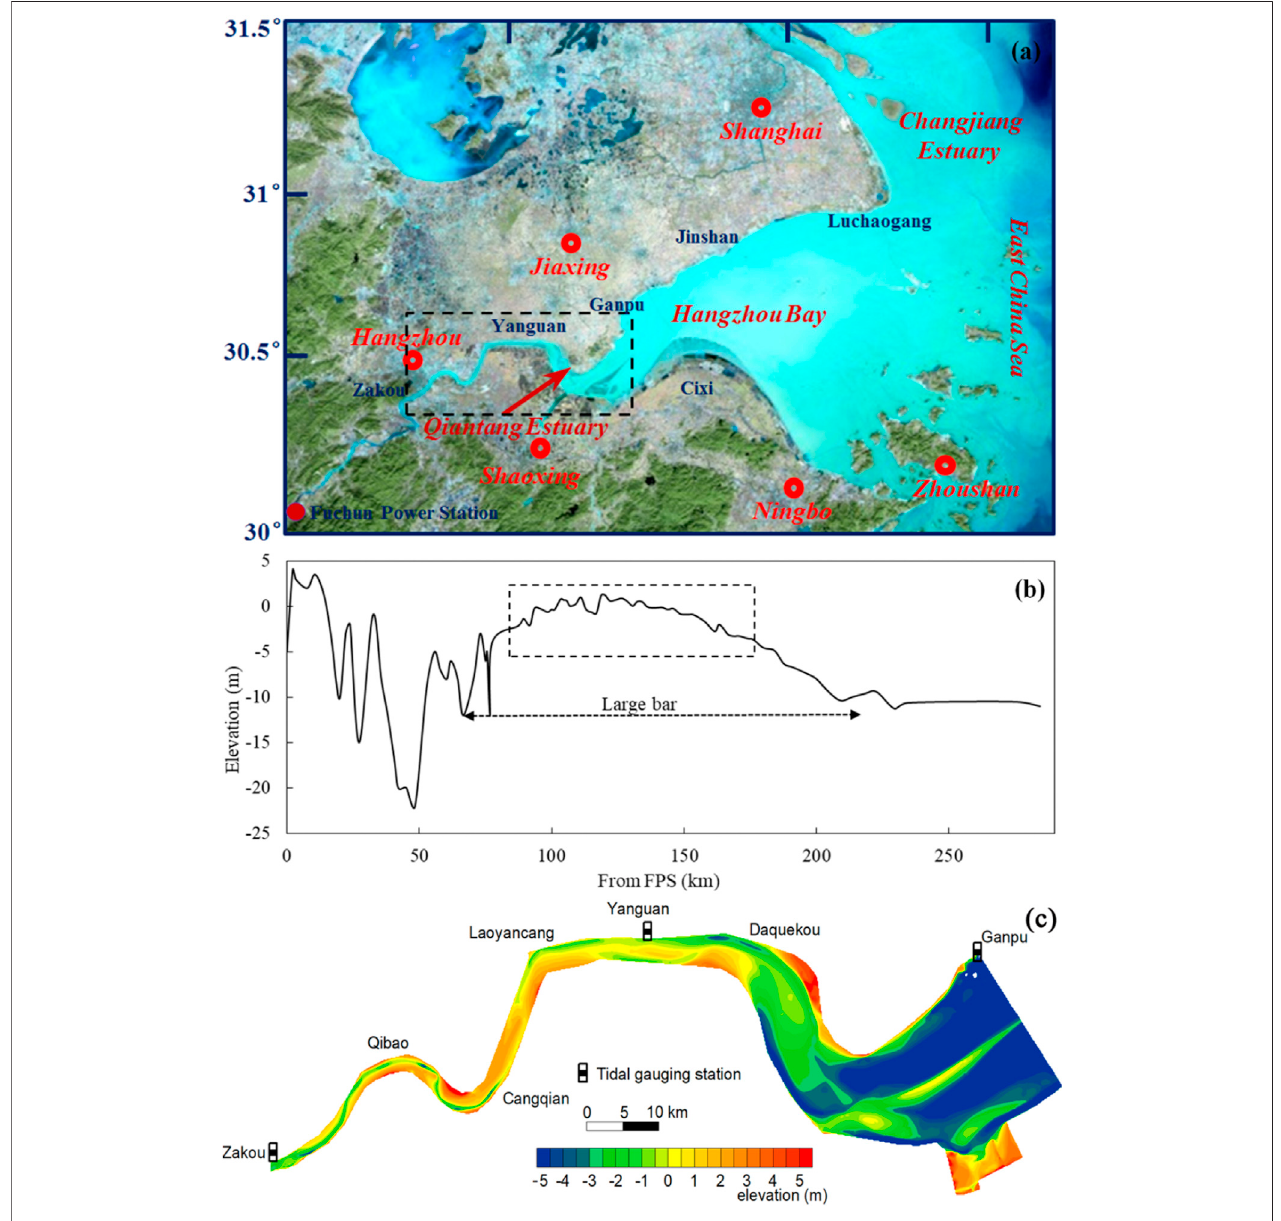
FIGURE 1 | (A) Location of the Qiantang Estuary, (B) the lateral-averaged longitudinal pro fi le along the estuary and (C) bathymetry of the Qiantang estuary in april 2015. Panels b and c are after Xie et al. (2017b) and Xie et al. (2018), respectively. The dashed line in panels (A) and (B) denote the Qiantang Estuary.